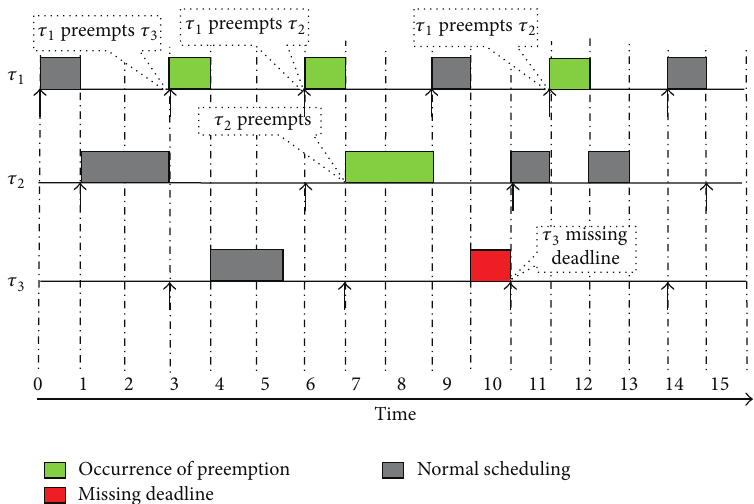
Figure 5: RM scheduling on single processor.